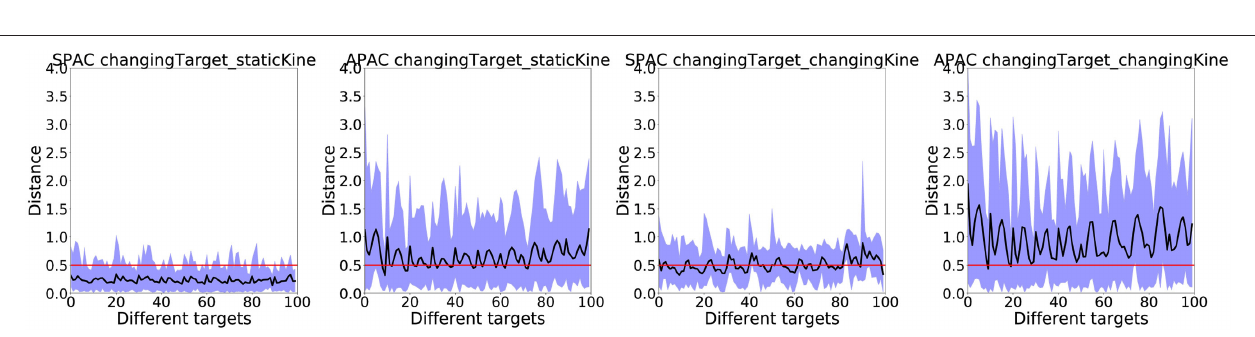
FIGURE 10 | The actual distance from the agent to the target location under changing target conditions are shown for SPAC and APAC to reach 100 targets after training over 50 runs. The black line shows the average distance to the target. The area between minimum distance to the maximum distance is colored in blue. The red line indicates the target zone. In general, SPAC performs better under the dark compared to APAC.